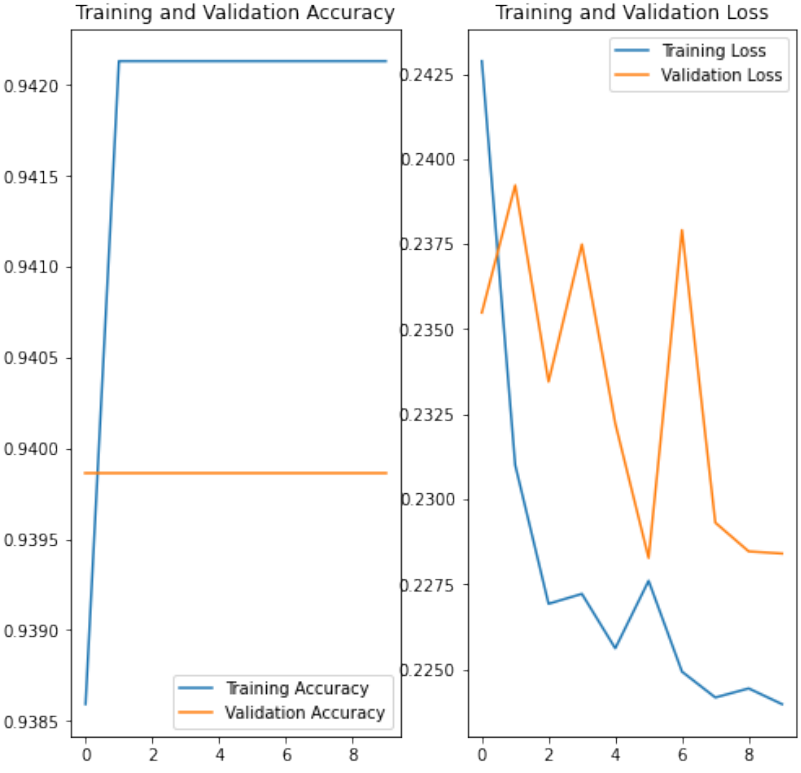
Figure 4. Validation accuracy and Training Loss of Coco Gray & Model 1 & 20 polyglots.